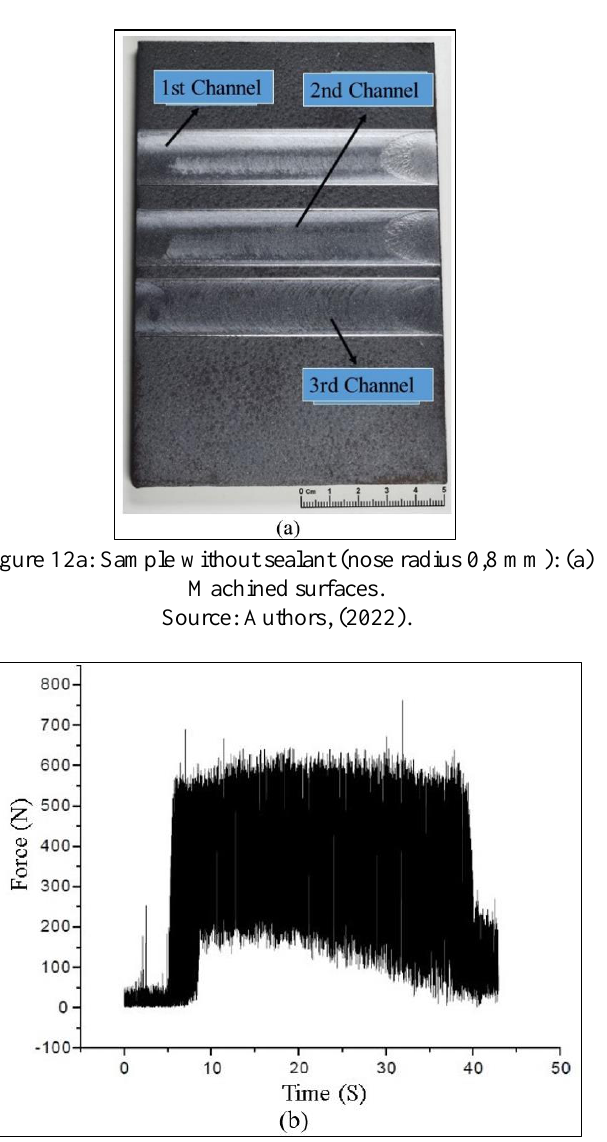
Figure 12b: Sample without sealant (nose radius 0,8 mm): (b) Force spectrum (3rd channel).